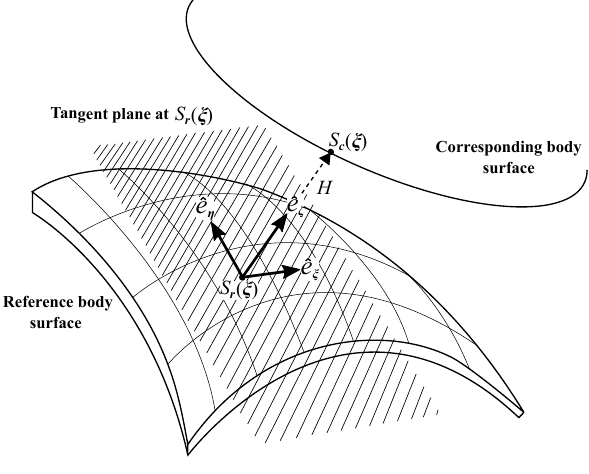
Figure 4: Coordinate frame with the basis { ˆ e ξ , ˆ e ζ , ˆ e η } and origin S r ( ξξξ ) at the reference body sur- face.